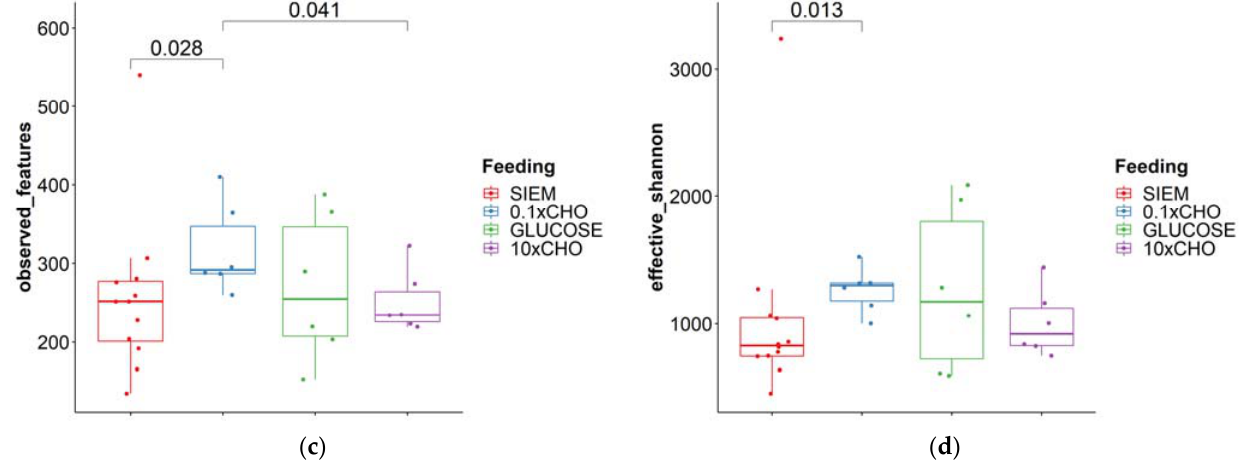
Figure 5. Alpha-diversity of the lumen samples during the intervention period; ( a ) observed features of fungi; ( b ) Shannon-diversity-index fungi; ( c ) observed features of bacteria; ( d ) Shannon-diversity-index bacteria. Pairwise comparisons Wilcoxon signed-rank test.